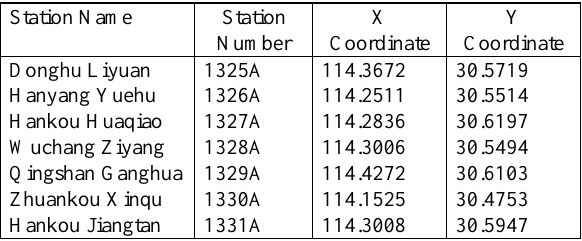
Table 1. Detailed information of nine stations within Wuhan The natural constitution is represented by NDVI, NDBI, MNDWI and Albedo. These indicators are calculated using the L1T product of Landsat-8 Operational Land Imager (OLI). The POIs and PTM are collected from the Baidu Map (http://lbsyun.baidu.com) and spatialized on ArcGIS